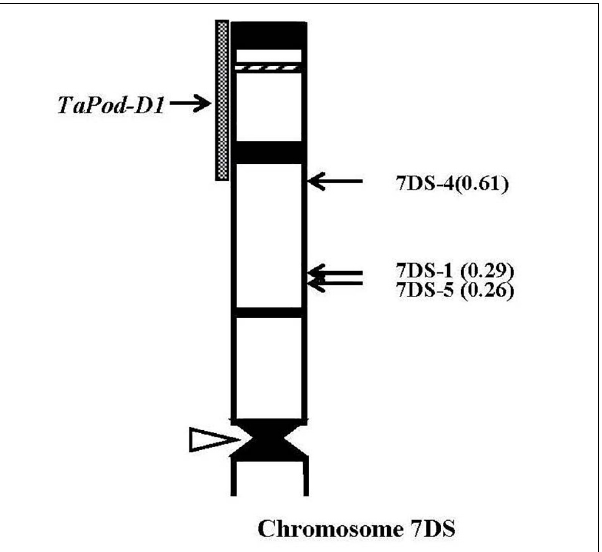
FIGURE 4 | Physical map of Chinese Spring (CS) chromosome 7DS. The identification of deletion lines and fraction arm length (FL) values of breakpoints ( parentheses ) is shown on the right . C-banding patterns of chromosomes are taken from Gill et al. (1991). The chromosomal region ( gray hatched bar ) from FL = 0.61 to FL = 1.00 indicates the putative location of the TaPod-D1 gene. Chromosome short arms point toward the top and the open arrow ( left ) shows the position of the centromere.